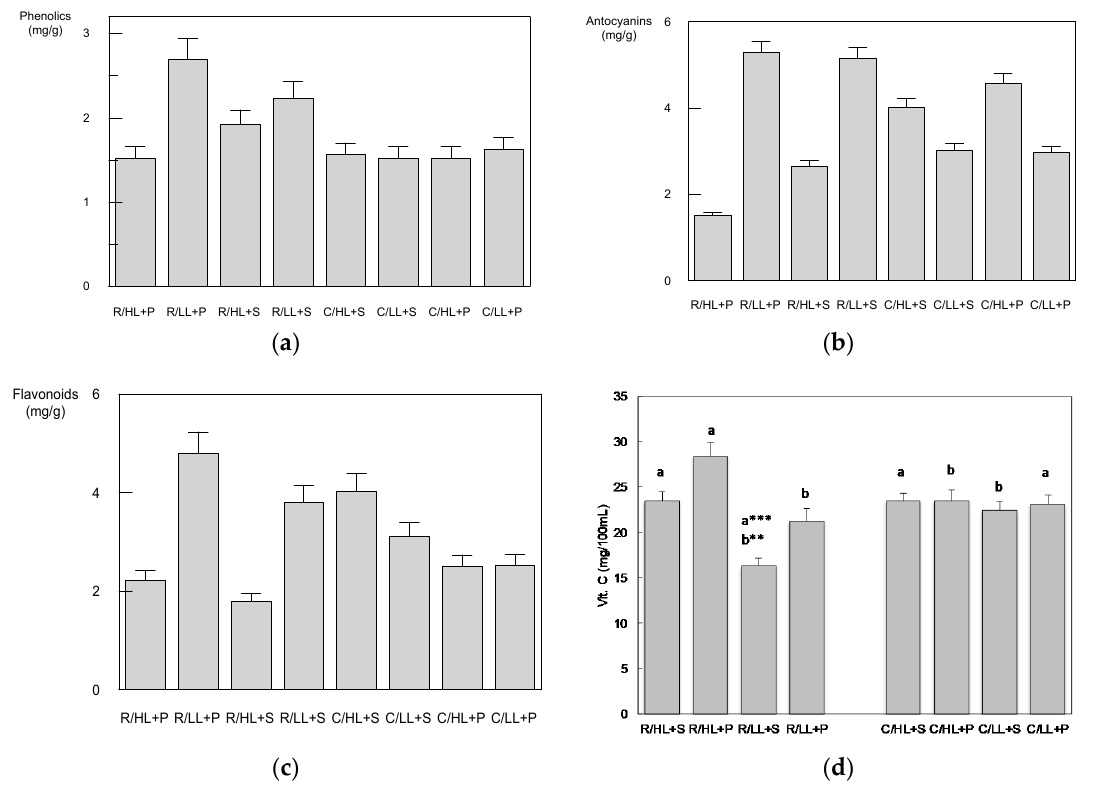
Figure 3. Selected secondary metabolites of Rubus idaeus L., fruits extract from two cultivars (‘Ruvi’ and ‘Cayuga’) growing under different light conditions and substrate composition. ( a ): total phenolics (expressed in mg of gallic acid equivalents/g lyophilized tissue); ( b ): total anthocyanins (expressed in mg of cyanidine-3-glucoside/g lyophilized tissue); ( c ): total flavonoids (expressed in mg quercetin equivalents/g lyophilized tissue); ( d ): Vit C concentration in mg/100 mL fruit extract. *** = p < 0.001; ** = p < 0.005; “a” and “b” represent the categories compared.